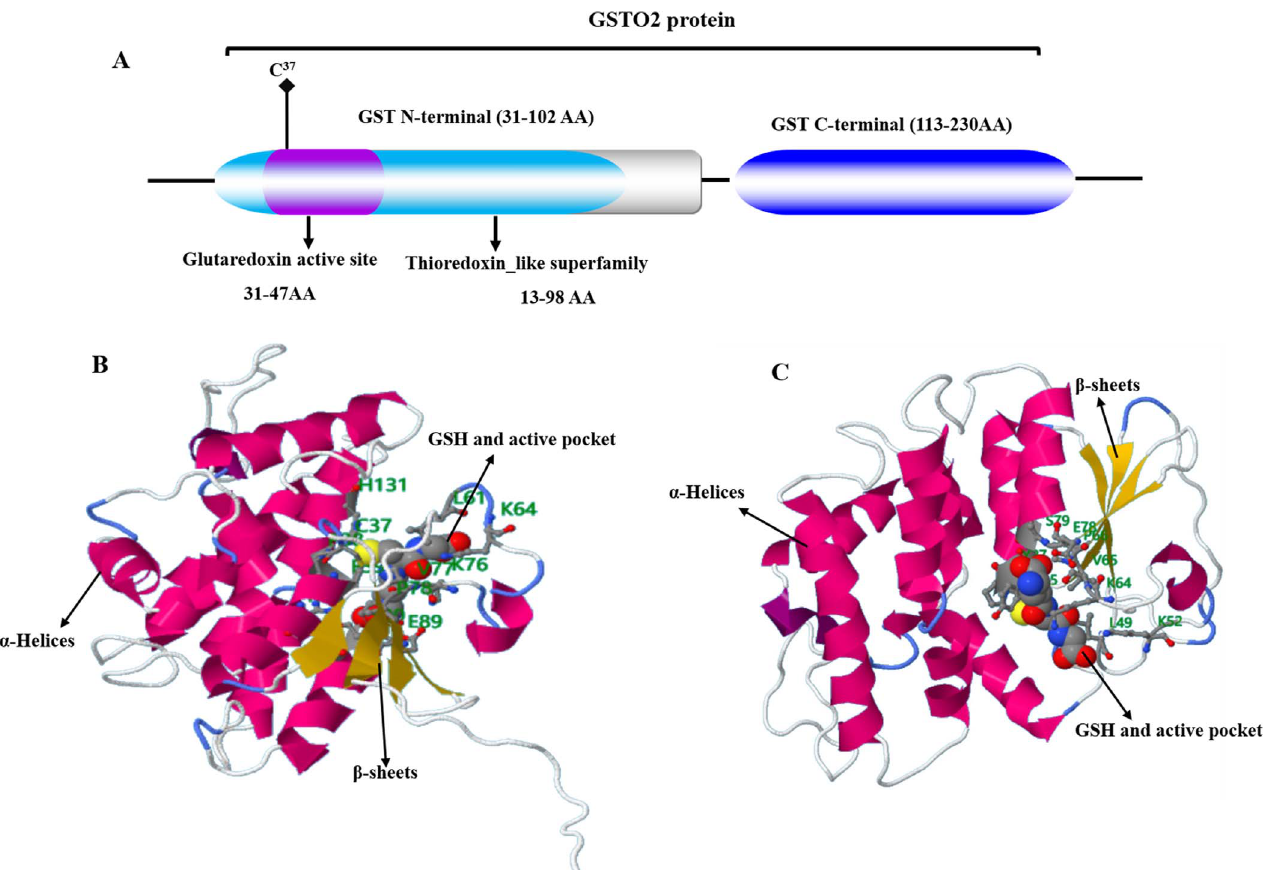
Figure 1. Molecular characteristics of omega-class GST of F. hepatica. (A) Schematic structural composition of the domains of GSTO2 protein. (B) and (C) represent the 3D structure models of GSTO2 and GSTO, respectively, which were built by I-TASSER. a -helices (red band) and b -sheets (yellow band) were connected by coils to form a stable tertiary structure. Key amino acids are marked by green